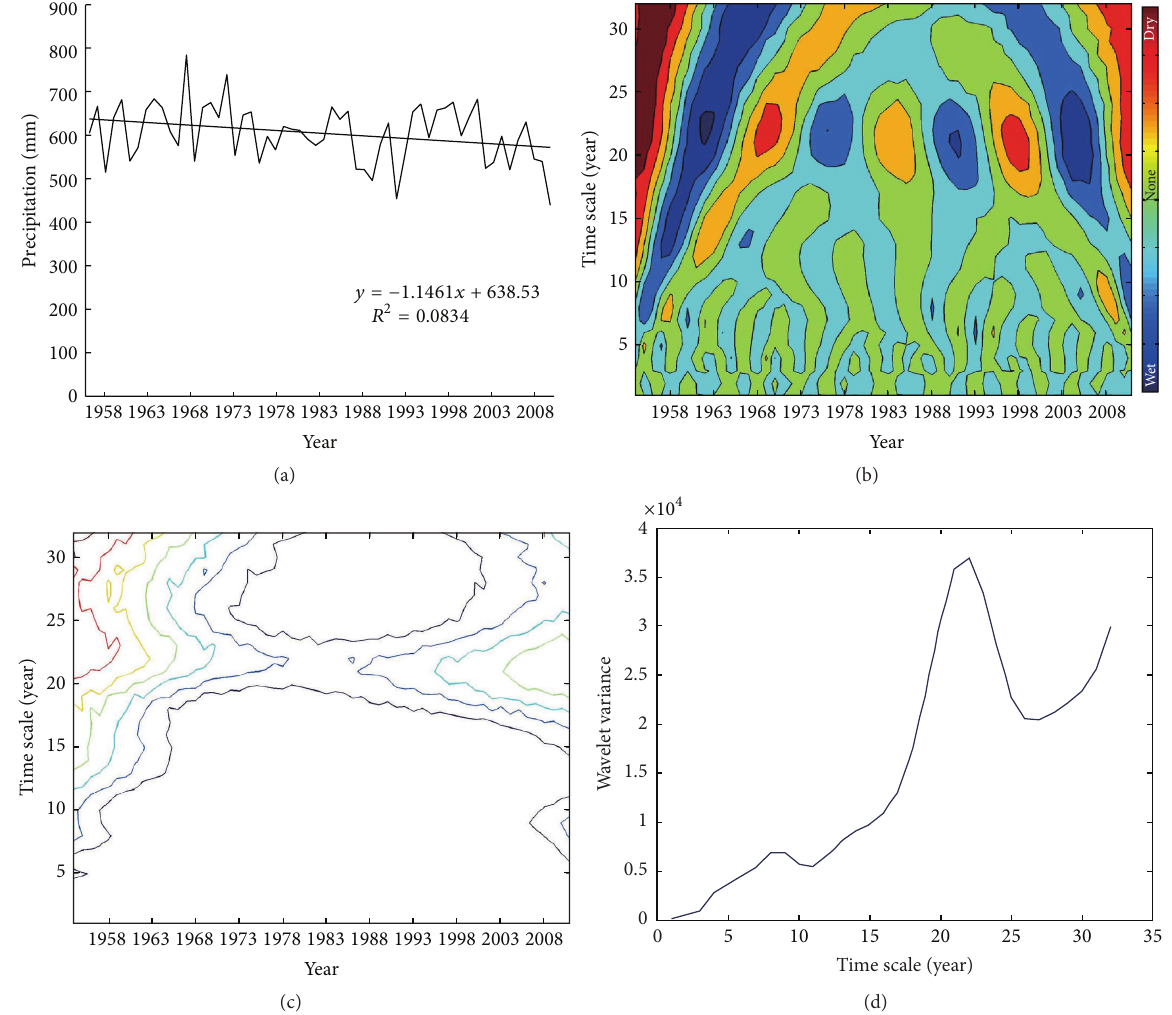
Figure 3: (a) Summer precipitation interannual change of Yunnan. (b) Summer precipitation wavelet transform of Yunnan. (c) Summer precipitation wavelet coefficients contour of Yunnan. (d) Summer precipitation wavelet variance of